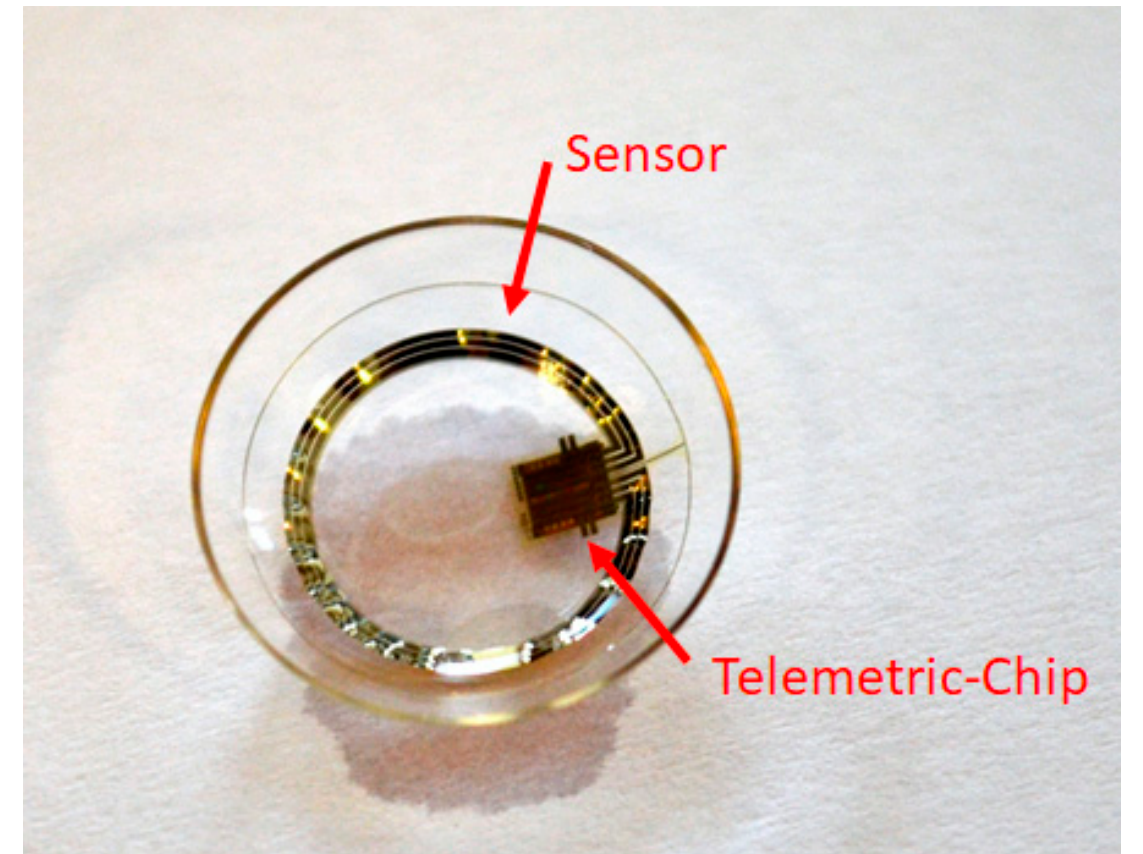
Figure 1. Triggerfish contact lens with sensor and Bluetooth.